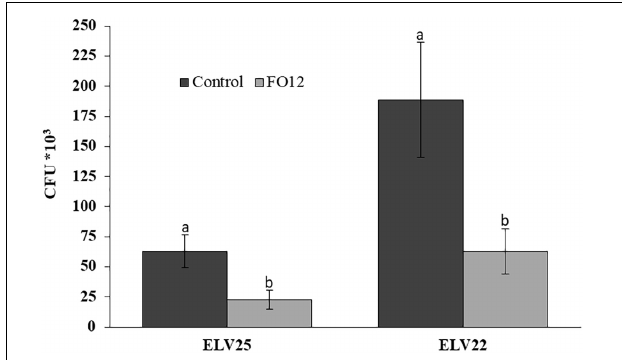
FIGURE 2 | Effect of volatile organic compounds (VOCs) from the non-pathogenic F. oxysporum strain FO12 on microsclerotia viability of V. longisporum ELV25 and V. dahliae ELV22. For each isolate, columns represent the means of 12 replicates per treatment. Vertical lines in each column are the standard error of the mean. For each Verticillium isolate, means in a column followed by a different letter are significantly different according to Fisher’s protected least significant differences (LSD) test at P = 0.05.